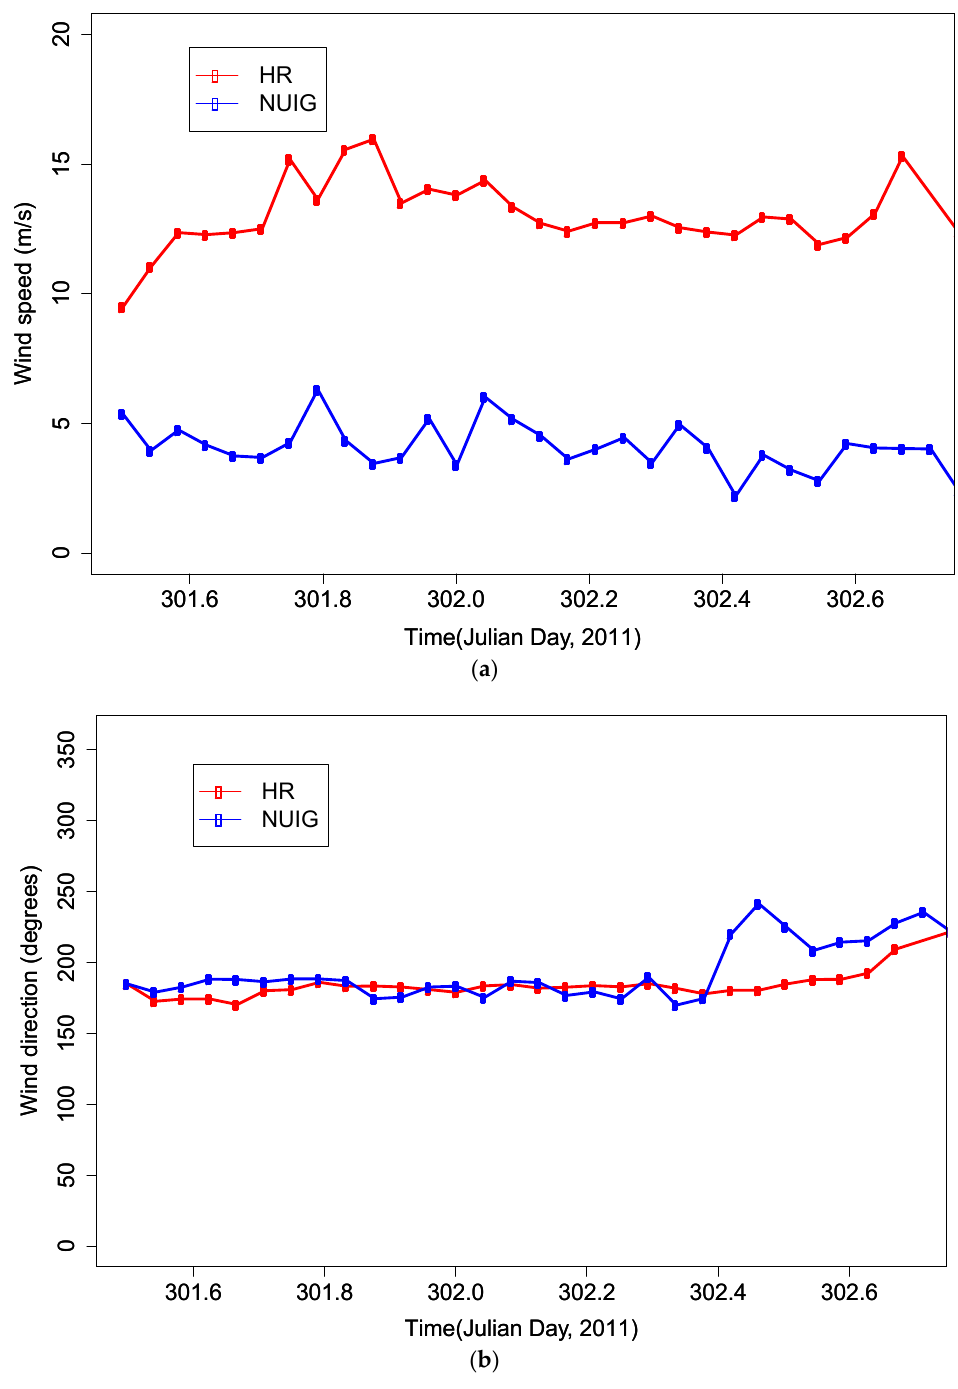
Figure 2. Comparison between modeled HR wind data and NUIG wind data at C1. ( a ) Wind speed, ( b ) wind direction).